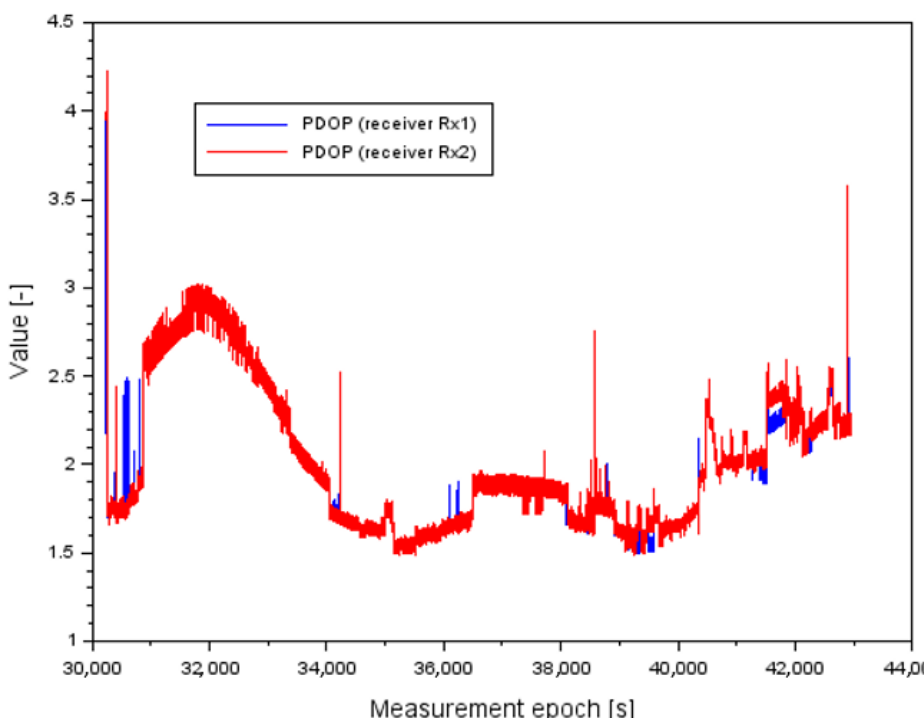
Figure 6. The PDOP values for SDCM solution for each receivers during the flight test. In Figure 7, the number of GPS satellites tracked by the Trimble Alloy and Septentrio AsterRx2i receivers during the flight is shown. It should be noted that the number of tracked GPS satellites represents the GPS satellites for which SDCM corrections were used in calculation within the SPP positioning method. For both the Trimble Alloy receiver and the Septentrio AsterRx2i receiver, the number of tracked GPS satellites ranged from 4 to 9 during the flight. With reference to the results in Figure 6, it should be noted that the PDOP decreases when the number of tracked GPS satellites increases.